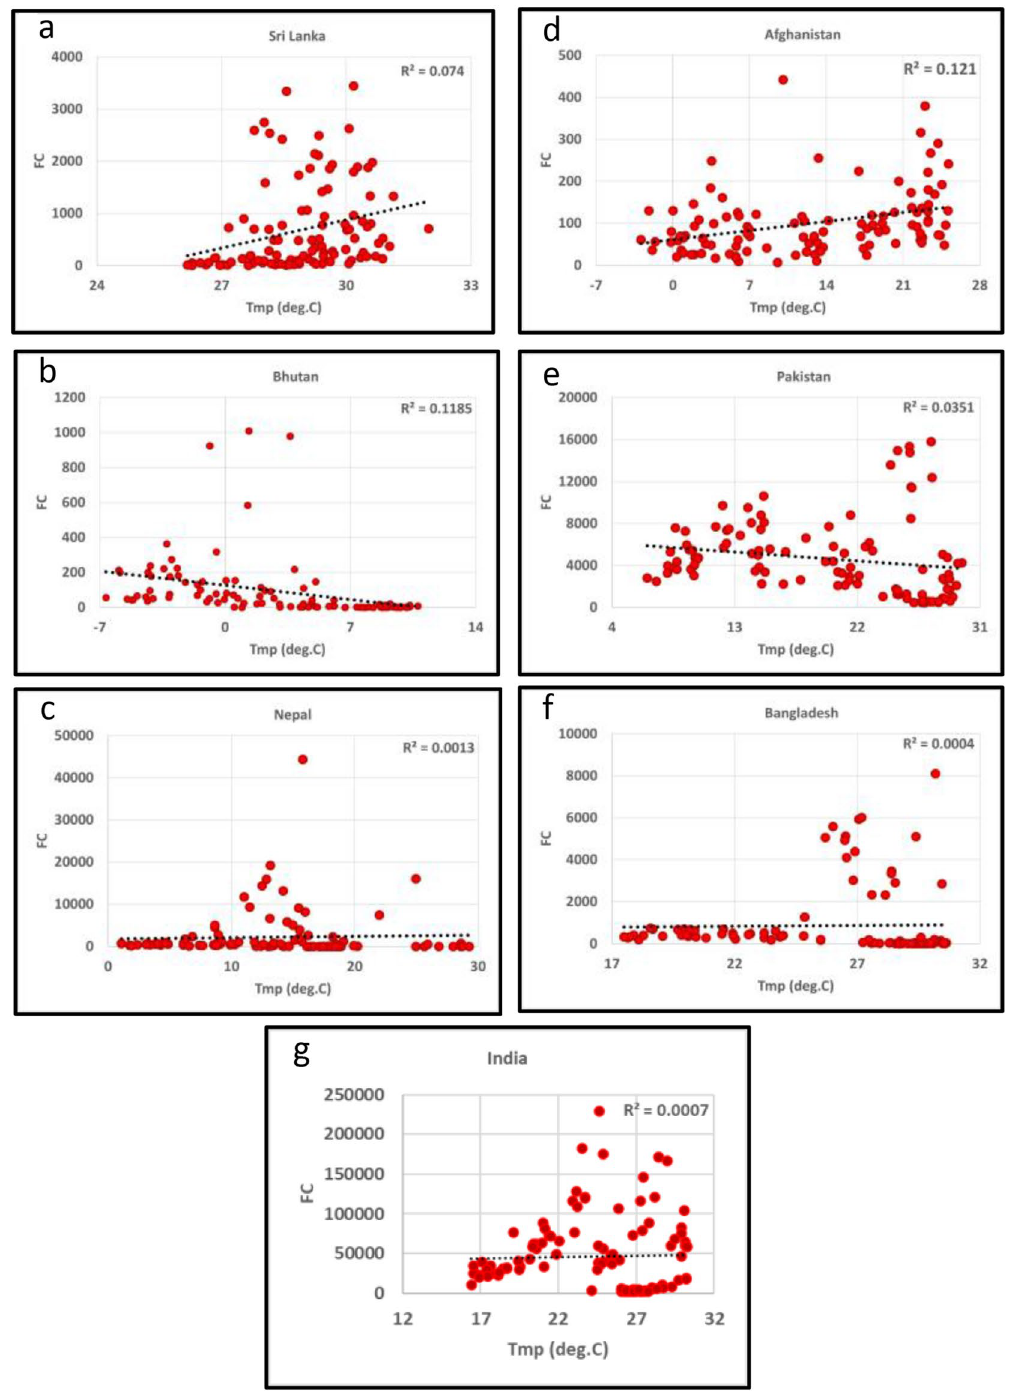
Figure 8. ( a )–( g ) Fire Counts (FC)-Temperature (Tmp) relationships in South Asian countries. Most of the correlations were